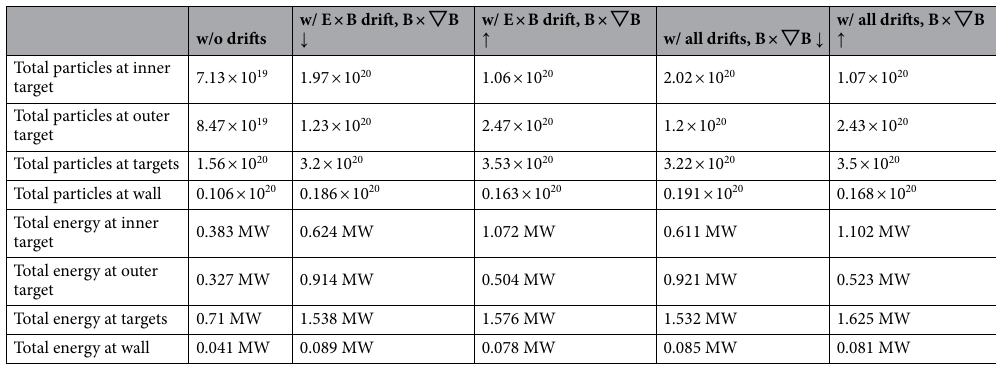
Table 3. Total particles and energy to the inner and outer divertor targets for cases without drifts, with E × B drift and with all